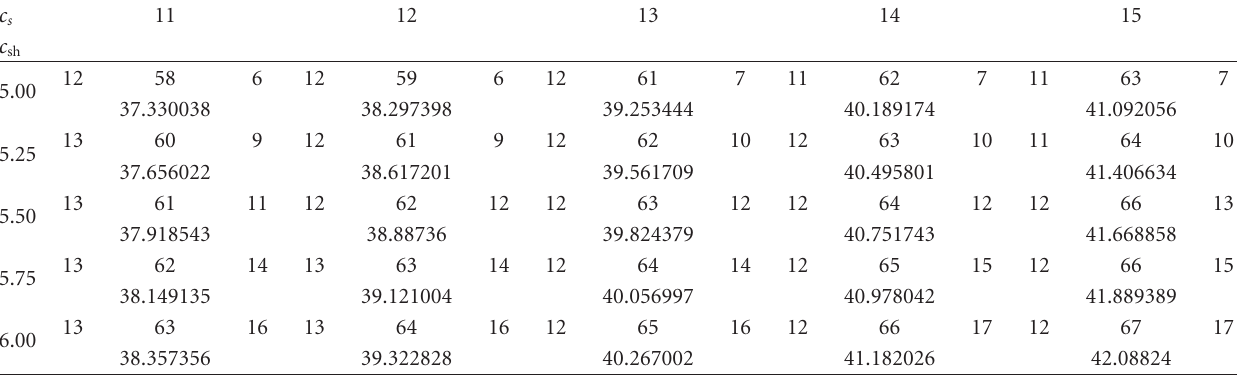
Table 17: Sensitivity of optimal values to variation in c s and c sh ( c h = 0 . 3, c p = 3, c pr = 0 . 3).